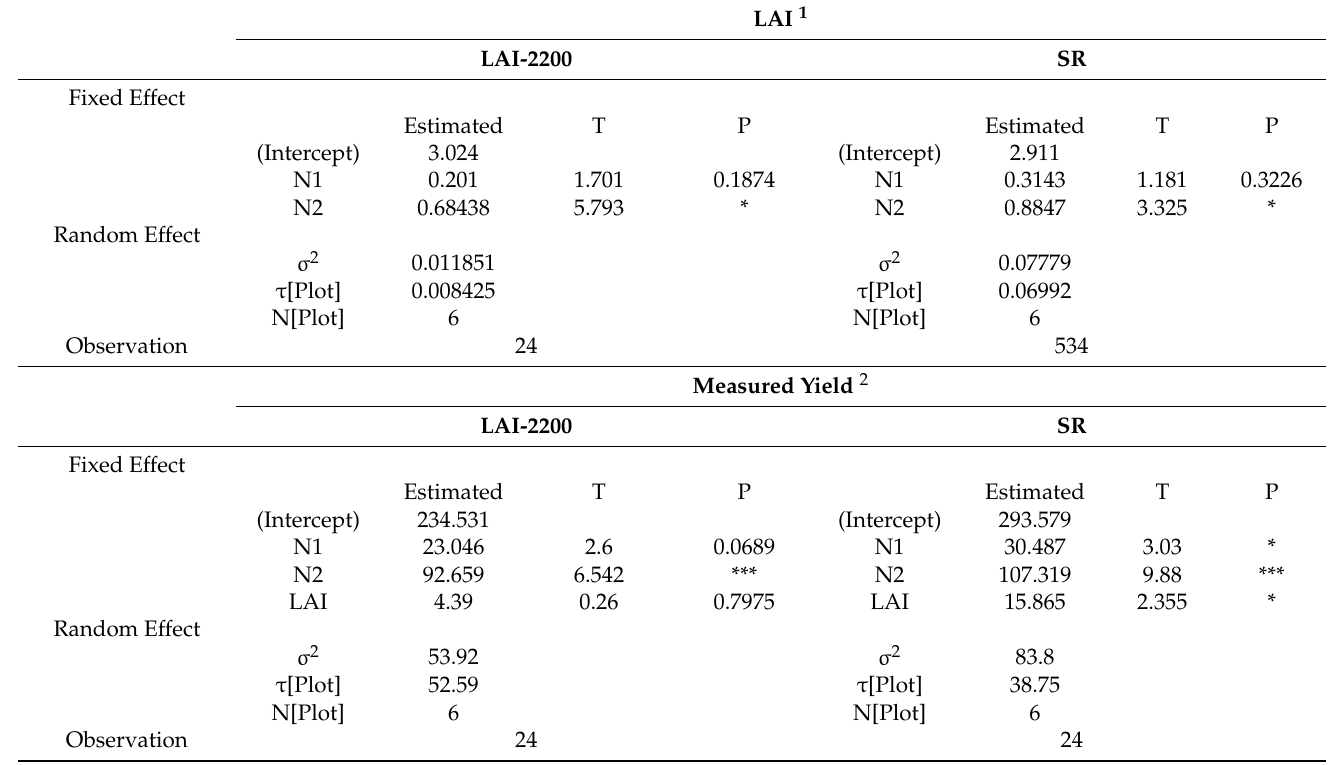
Table 2. Linear mixed model analysis of the LAI and the measured yield in